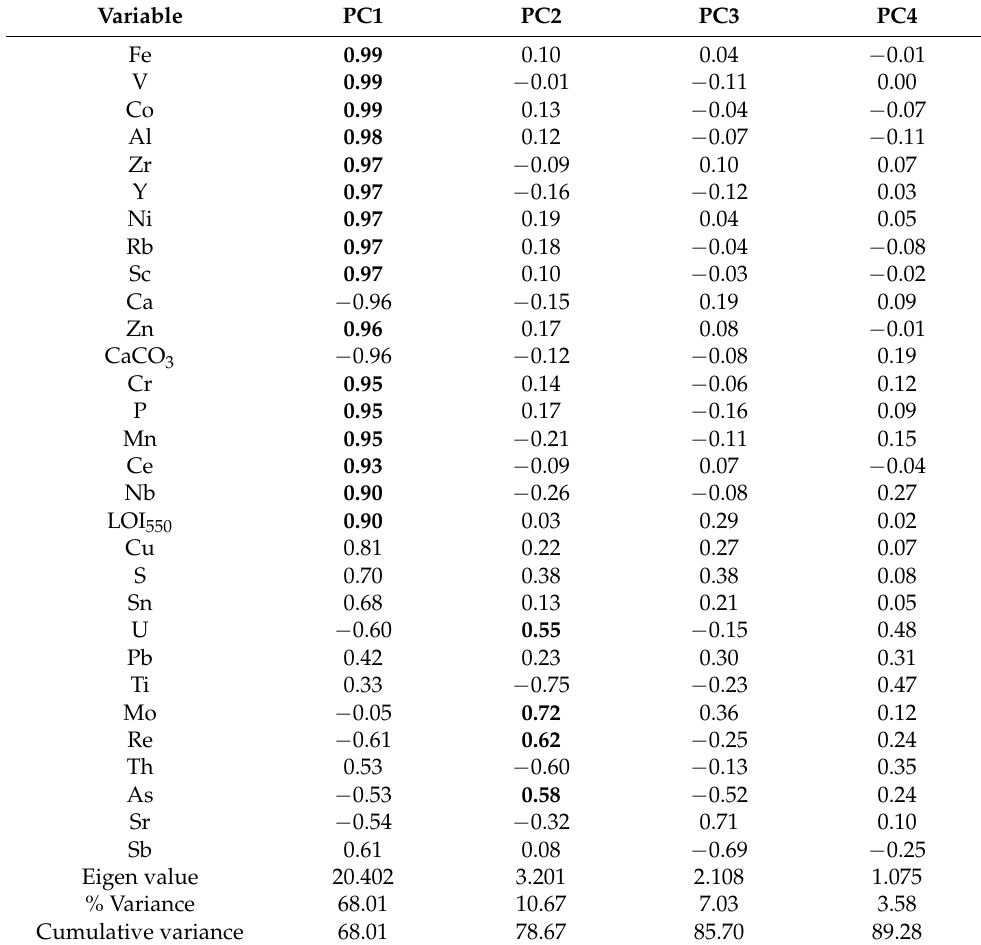
Table 3. Results of principal component (R-mode) analysis, four components (PC1-PC4) extracted with the PC1 and PC2 are the most important. Significant values are in